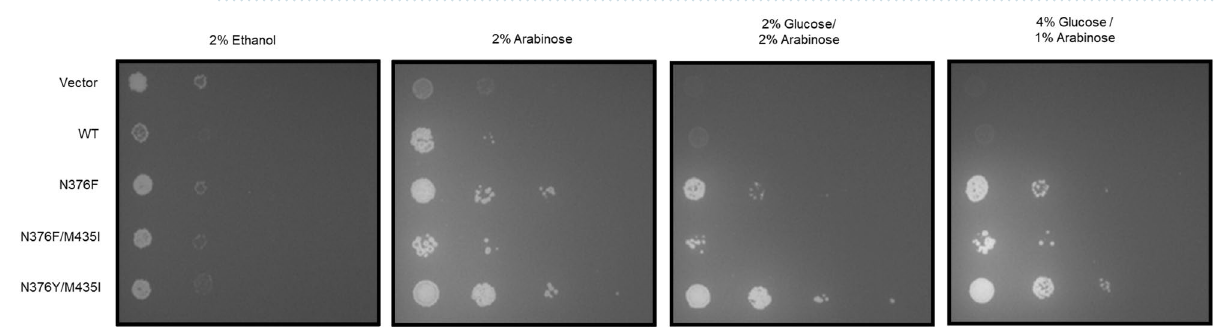
Figure 5. Growth conferred by different Gal2 variants on arabinose-containing media. The strain AFY10 was transformed with 2μ plasmids expressing the indicated Gal2 variants in combination with three additional 2μ plasmid expressing araA, araB and araD. The transformants were pre-grown in liquid selective SC medium with ethanol as a permissive carbon source and spotted onto selective SC solid medium containing the indicated carbon sources. Cells were grown at 30 °C for 6